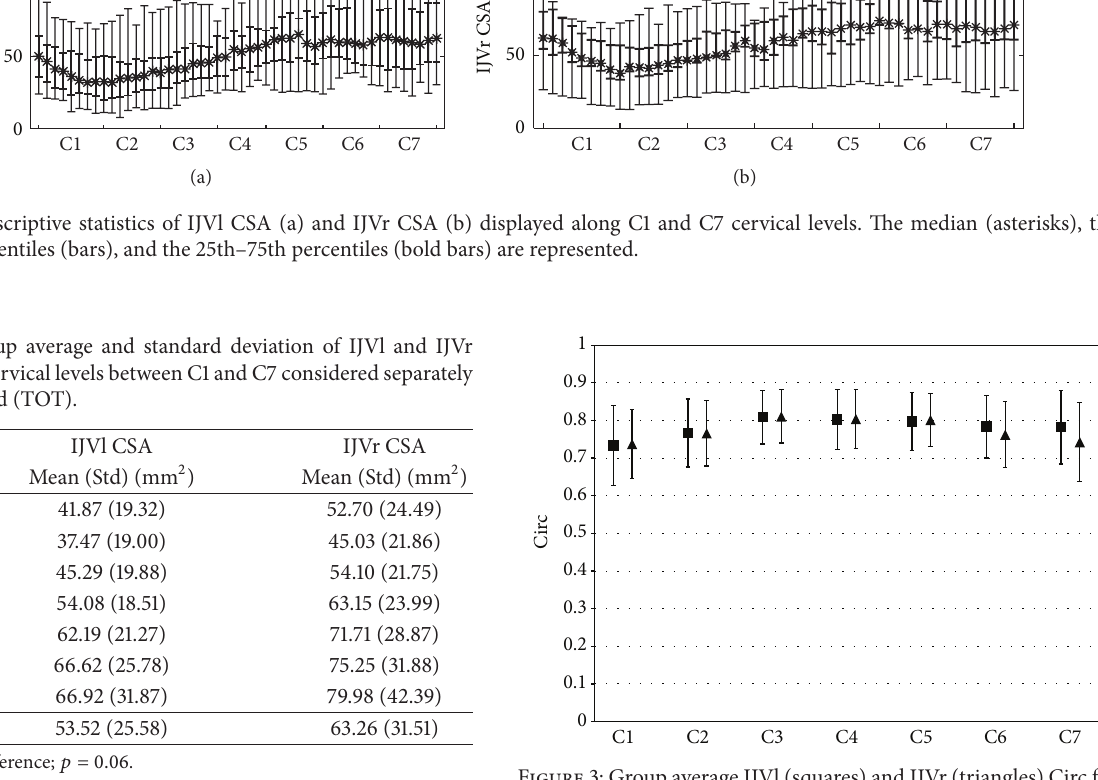
Figure 3: Group average IJVl (squares) and IJVr (triangles) Circ for each cervical level. Bars represent standard